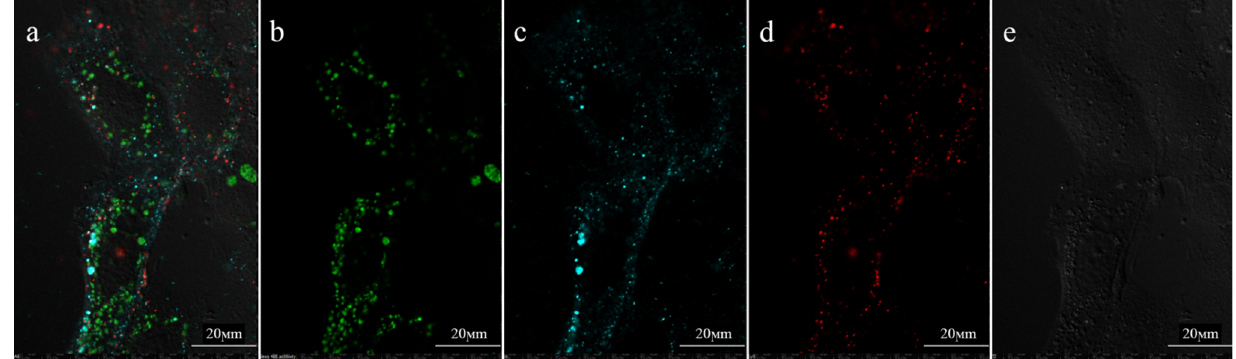
Figure 4. Internalization of hMNP-Cy3 and PLGA-Cy5 NP into 4T1 cells (40 min of incubation): ( a ) merged image; ( b ) lysosomes (Lysotracker Green DND26); ( c ) hMNP-Cy3; ( d ) PLGA-Cy5 NP; ( e ) cell contours—differential interference contrast (DIC). Scale bar—10 µm.